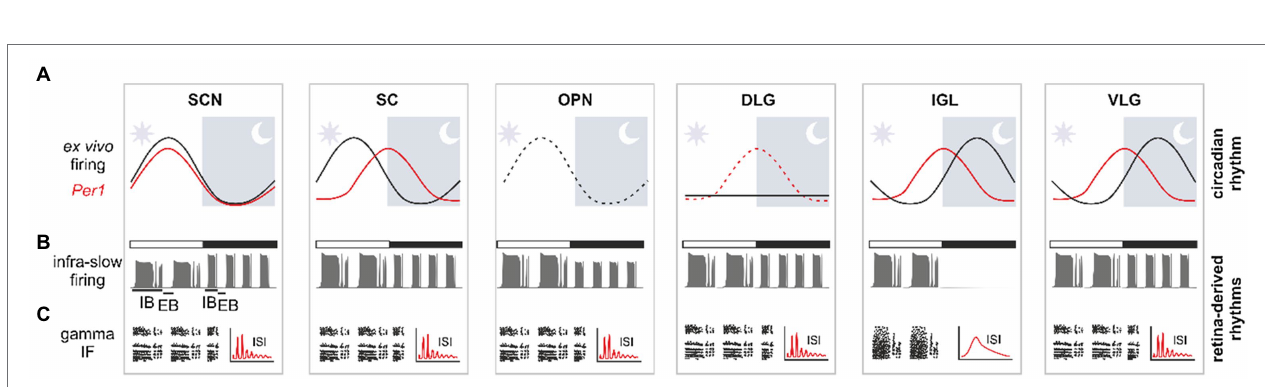
FIGURE 2 | Multi-frequency organisation of oscillatory signals in the SVS. (A) Black and red sinewaves, respectively, representing the oscillatory relationship between spontaneous firing and Per1 expression over a 24-h period ex vivo . The dotted black line in the olivary pretectal nucleus (OPN) is an extrapolation based on two daily time points. The horizontal black line in the dorsolateral geniculate nucleus (DLG) demonstrates a lack of daily rhythms in neuronal activity ex vivo . The red sinewave represents rhythmic core clock gene Per1 expression in the SVS areas, with a dotted red line in the DLG coding its rhythmicity in vivo only. (B) Infra-slow rhythm is modulated by ambient light conditions. White bar shows light-adapted conditions, whereas black bar – dark-adapted recording. Note the enhanced frequency in darkness for most SVS areas, or a total silencing in the intergeniculate leaflet (IGL). (C) Gamma oscillation presented as the notable bands in the instantaneous frequency (IF) plots and as a multimodal inter-spike interval (ISI) histogram. The IGL stands an exception, with no gamma oscillation recorded in this structure. IB, intra-burst; EB, extra-burst phase; SCN, suprachiasmatic nucleus; SC, superior